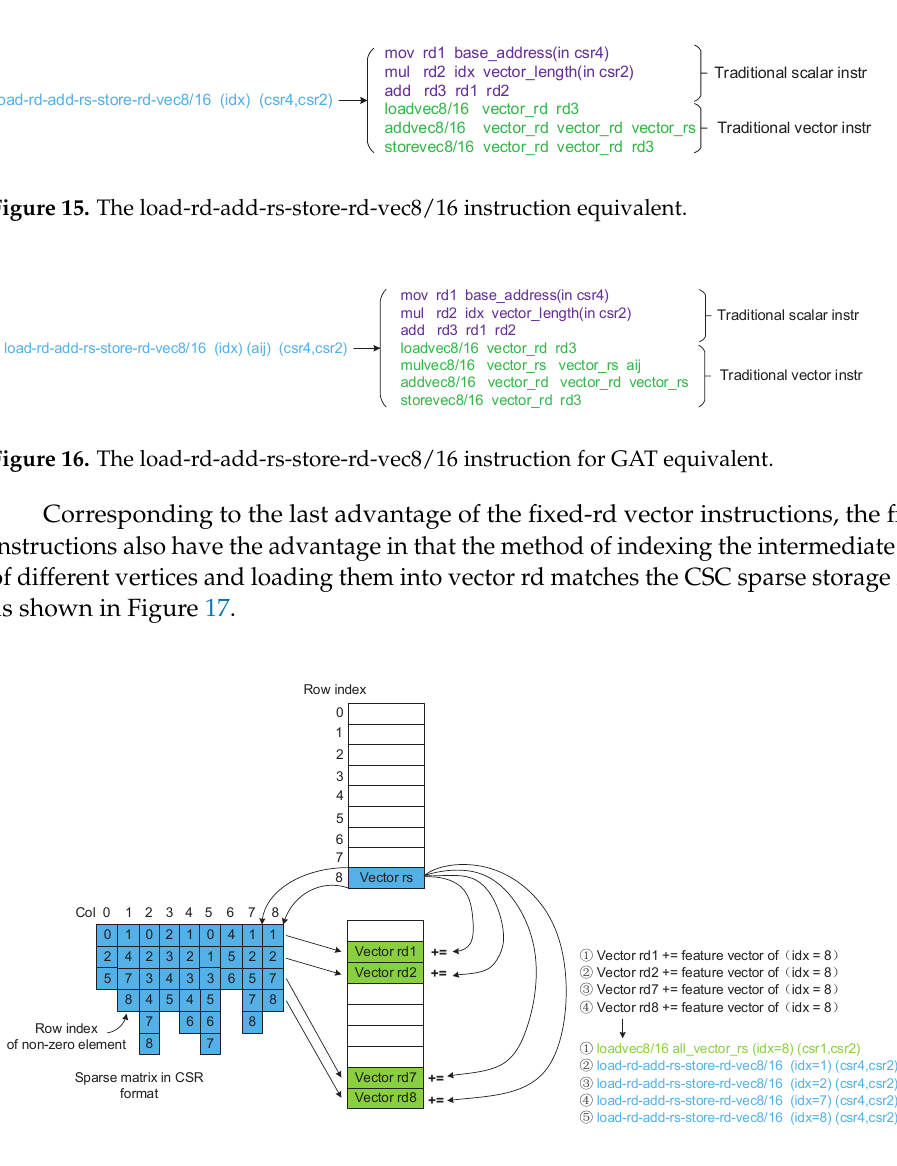
Figure 17. The computation process of fixed-rd mode with CSC data